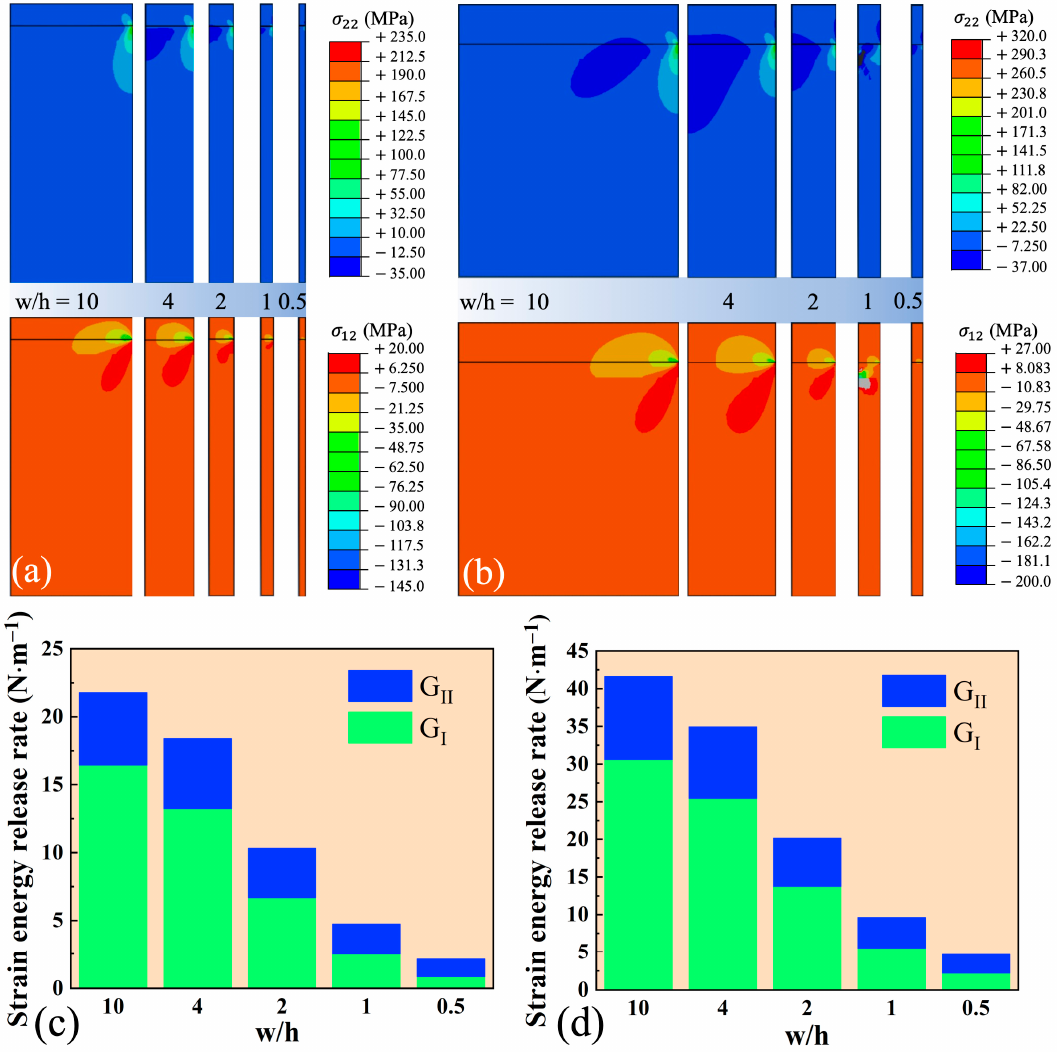
Figure 15. Effect of vertical cracks on stress distribution in ( a ) 0.3 and ( b ) 0.6 mm TCs. Driving force (SERR) of cracks in ( c ) 0.3 mm, ( d ) 0.6 mm thick TCs.